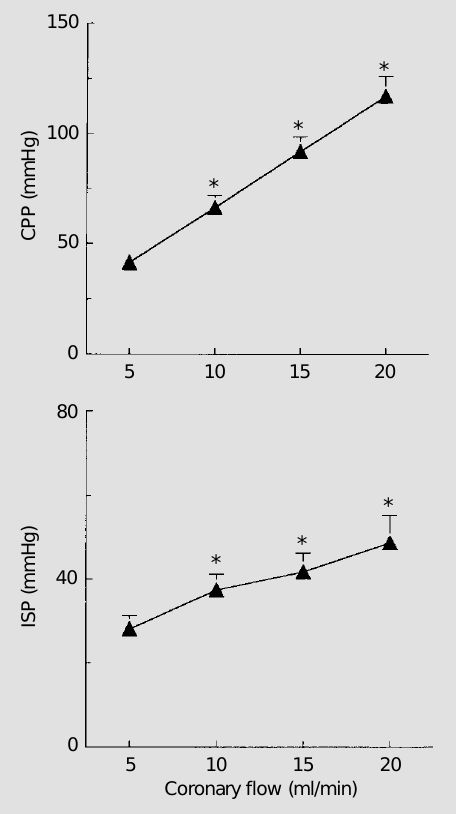
Figure 1 - Effects of increases of coronary flow on coronary perfu- sion pressure (CPP) and isovol- umic systolic pressure (ISP) of Langendorff-perfused hearts un- der control conditions. Each point indicates the mean ± SEM (N = 7). *P<0.01 vs the smaller flow (one-way repeated meas- ures